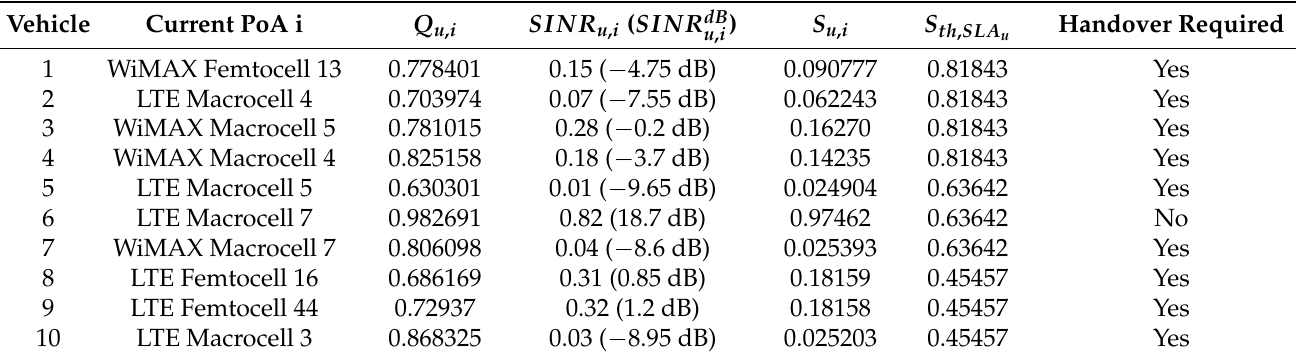
Table 4. The results of the HO initiation